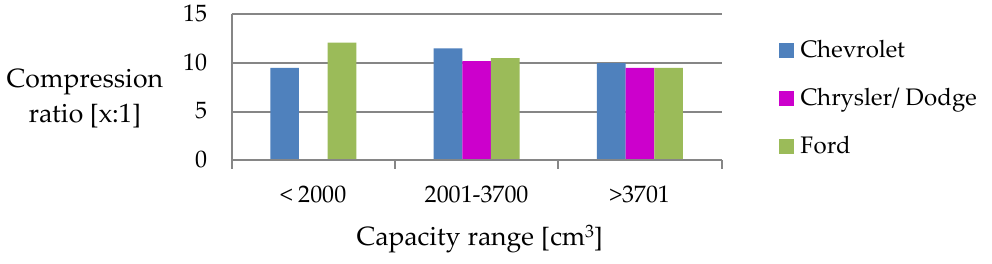
Figure 11. Maximum power in individual engine capacity ranges among American car brands. Source: Developed own.